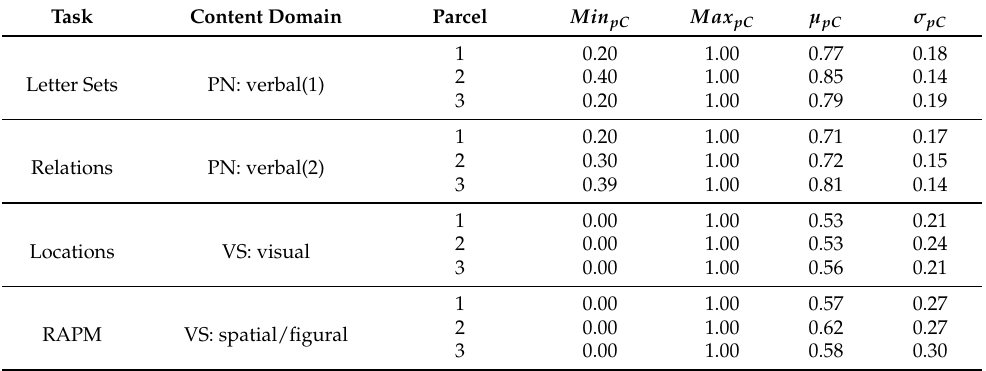
Table 1. Descriptive statistics for the average performance in the fluid intelligence